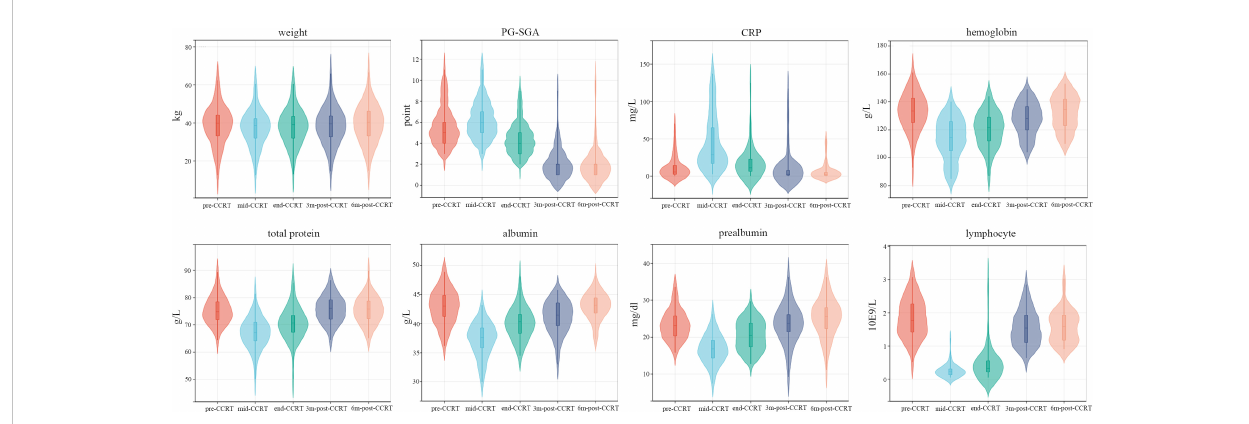
FIGURE 4 The changes longitudinal of nutrition-related indicators. mid-CCRT , 2 weeks after the start of CCRT; end-CCRT , the end of CCRT; 3m-post-CCRT , 3 months after CCRT; 6m-post-CCRT , 6 months after